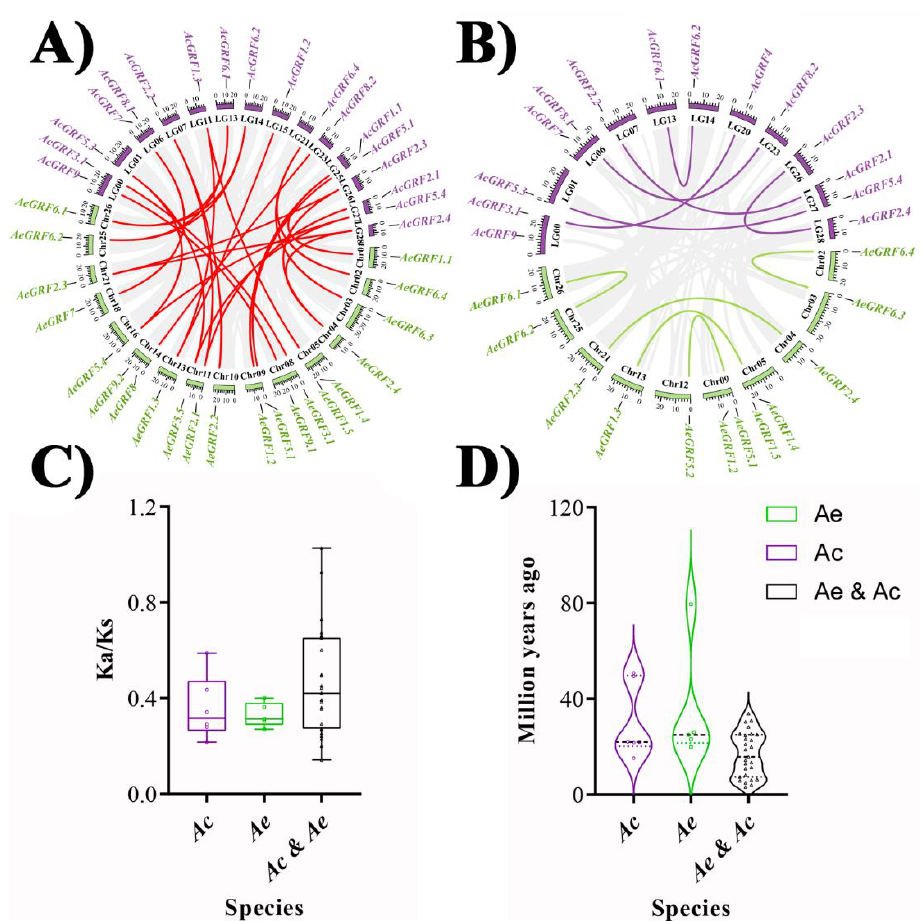
Figure 4. Collinearity analysis for kiwifruit GRFs . ( A ) Identification of ortholog gene pairs for Ae vs. Ac genomes. ( B ) Identification of paralog genes pairs for Ac vs. Ac genomes and Ae vs. Ae genomes. ( C ) Selection pressure calculation for GRF ortholog and paralog gene pairs between and within Ae and Ac genomes. ( D ) Calculation of divergence time (T). The grey lines in the background indicate all syntenic blocks between and within Ae and Ac genome, and colored lines indicate syntenic kiwifruit GRFs gene pairs.